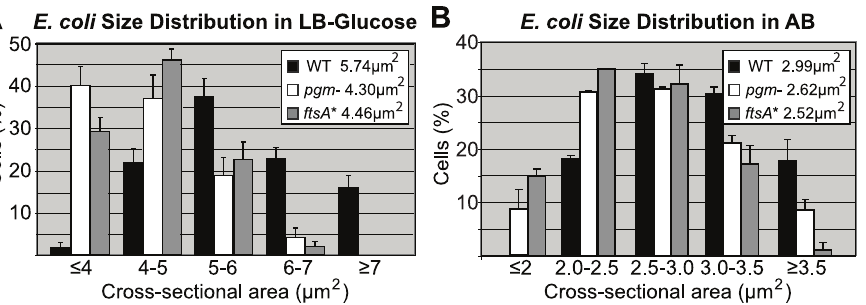
Figure 1. Distribution of cell size. Histograms of wild type and mutant E. coli cell size after growth in either (A) LB-glucose or (B) AB. Here, cross- sectional areas were used as proxy for cell size and the mean sizes are shown in the inset. Note that the size distributions of both the pgm :: kan and ftsA* cells are shifted to the left. Experiments were done in triplicate counting . 200 cells per strain. Error bars equal one standard deviation. The mutants were significantly smaller in both LB-glucose (p , 0.001) and AB (p , 0.01) by chi-square analysis.